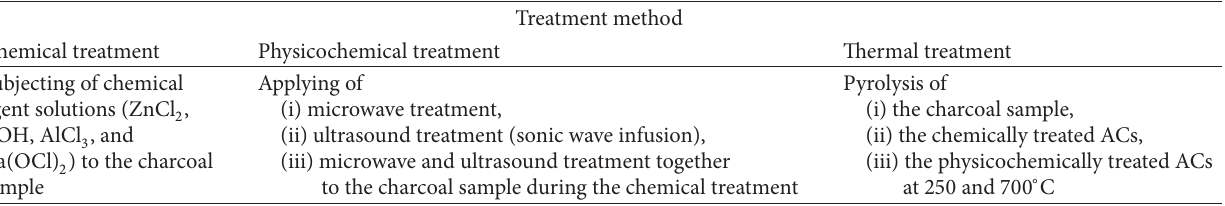
Table 1: Treatment methods applied for obtaining of different ACs from charcoal samples that were obtained by pyrolysis of raw hazelnut shells at 250 ∘